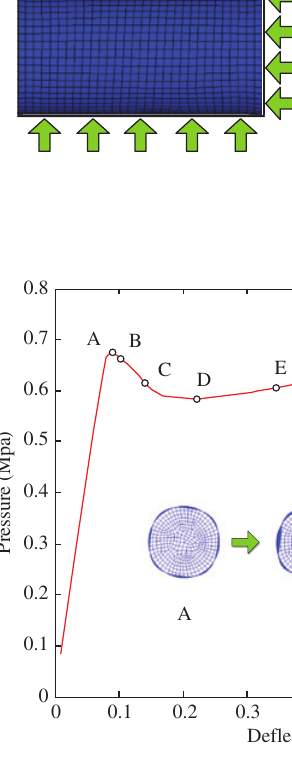
Figure 9: Typical pressure vs. deflection curves of the composite cylinder (CTM3). than 1 from layer nos. 1 to 24, and no failure was